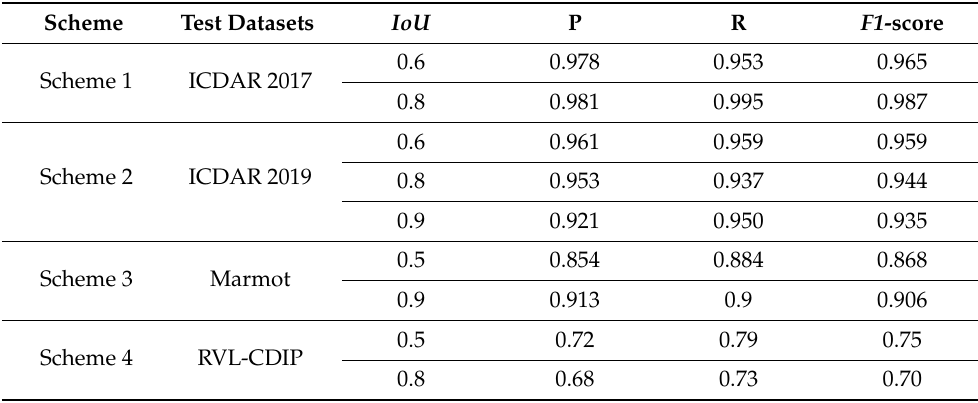
Table 5. Evaluation with leave-one-out scheme of DCTable on ICDAR2017, ICDAR 2019, Marmot and RVL